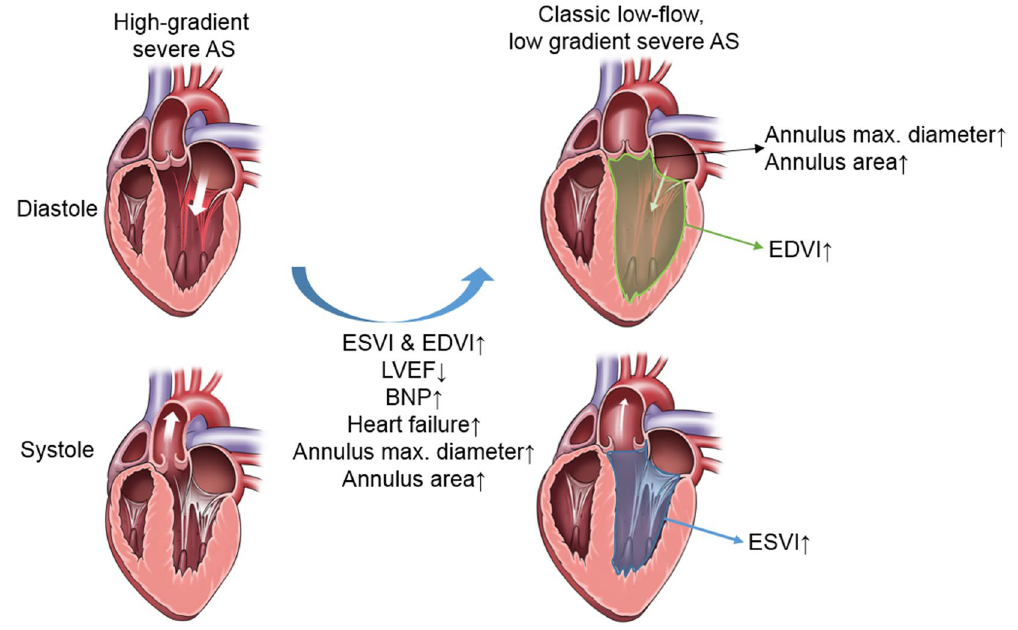
Figure 5. Characteristics of classic LF-LG AS. Classic LF-LG AS patients demonstrated higher ESVI and EDVI, lower LVEF, larger aortic annulus diameter and area compared to high-gradient severe AS. The drawings